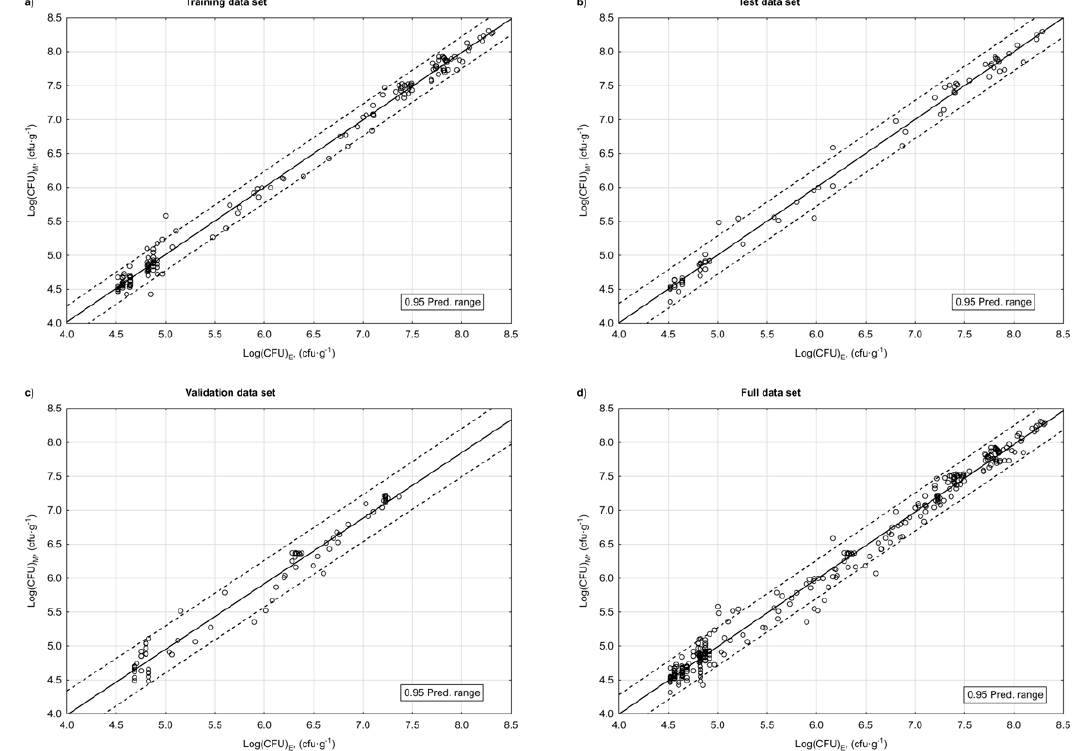
Figure 7. Levels of mold contamination in rapeseed ecosystems with water activity a w = 0.75–0.90 Figure 7 stored at 12–30 ◦ C predicted by the MLP neural network model (Log(CFU) M against experimental levels of the fungal population (Log(CFU) E ) adopted from Wawrzyniak et al. [6] for ( a ) training, ( b ) test, ( c ) validation, and ( d ) full data